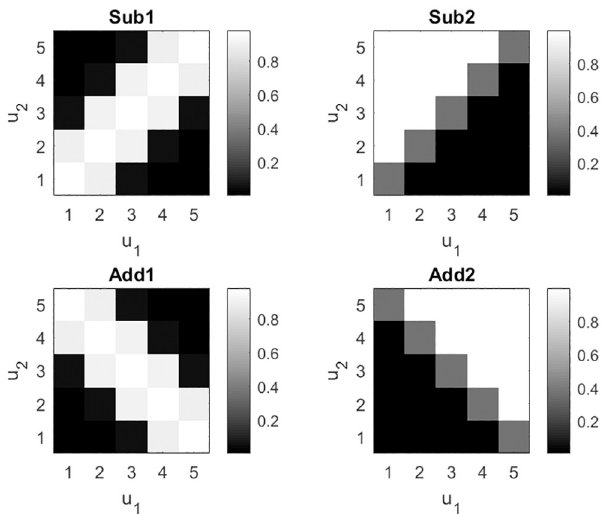
Fig 2. Stimulus-reward maps. Each gray scale image plots the reward probability (given button press “g” i.e. choosing Sun for Task 1 and Heads for Task 2) as a function of stimulus, u . The variables u 1 and u 2 denote the number of slices in the left and right pie stimuli, respectively. Each task can be implemented using two-stages of processing. For example, for the Sub1 and Sub2 maps the first stage requires extraction of a feature, x = u 1 − u 2 . For Add1 and Add2 the required feature is x = u 1 + u 2 . Tasks which use the same stimulus to feature space function (ie. subtraction or addition) are said to share the same subspace.